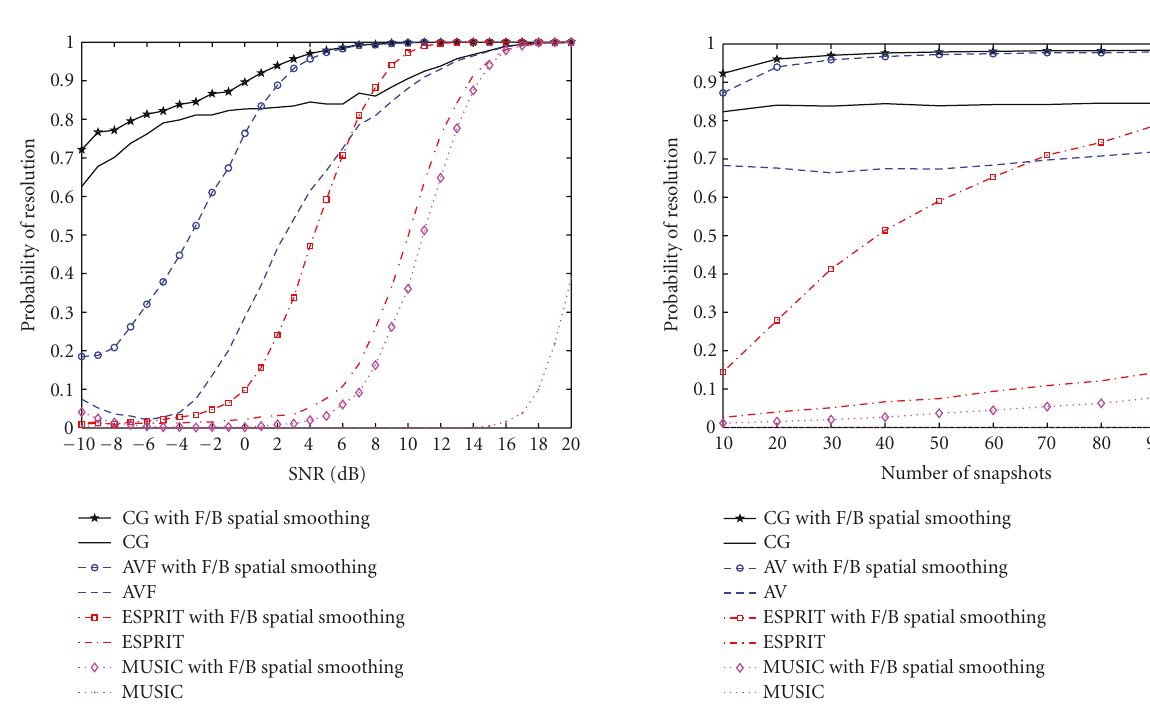
Figure 7: Probability of resolution versus number of snapshots (separation 3 ◦ , SNR = 5dB, r = 0 .